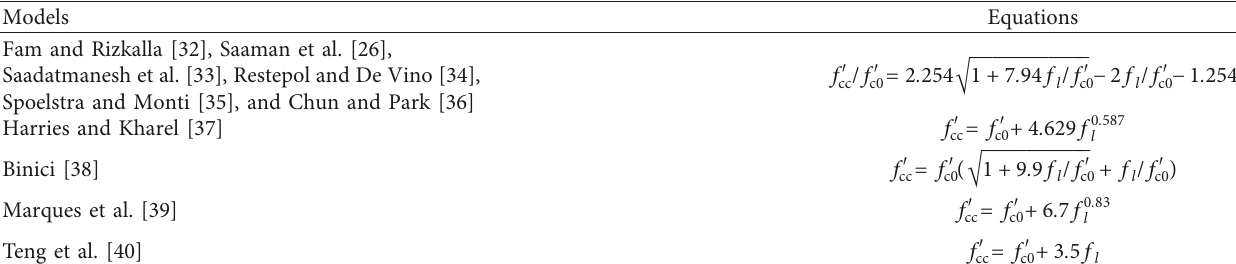
Table 4: Coefficient of analysis-oriented confinement models.